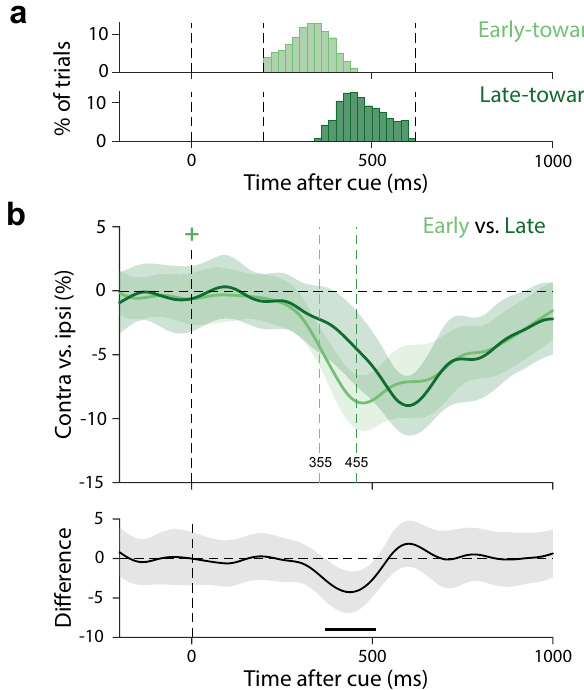
Fig. 4 Microsaccadic and neural modulations by internally directed spatial attention co-vary in their timings after the selection cue. a Group- level distributions of microsaccade onset latency in trials with early (top) and late (bottom) microsaccades. Early and late were de fi ned based on a median split that was performed separately for each participant (resulting in some overlap in this group-level visualization). b Overlay and comparison of the spatial alpha modulation in toward-microsaccade trials in which the fi rst toward microsaccade was detected relatively early or late. Black horizontal line indicates the signi fi cant temporal cluster (two-sided cluster- based permutation test). Time courses show mean values, with shading indicating 95% CI (calculated across 23